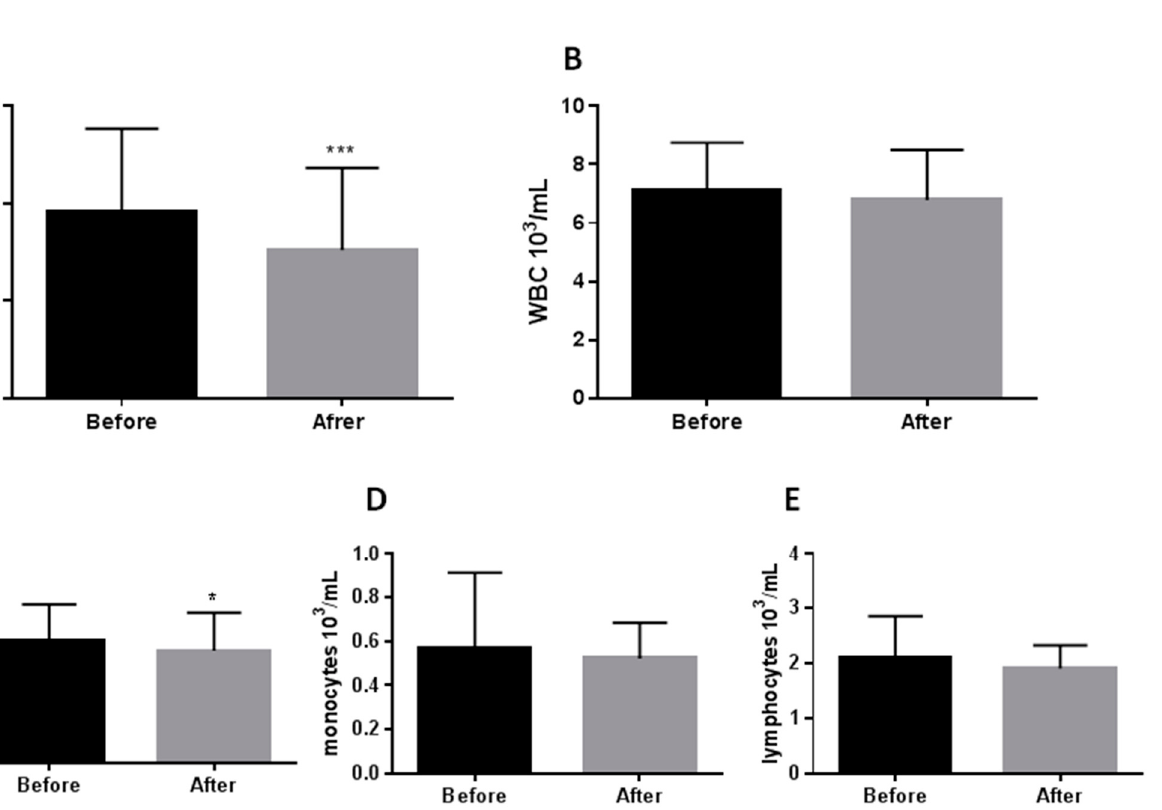
Figure 1. Effect of 8 week caloric restriction on serum myeloperoxidase activity ( A ), total white blood cell count ( B ), neutrophile count ( C ), monocyte count ( D ), and lymphocyte count ( E ). The data were analyzed using the paired t -tests (Gaussian distribution: the paired test; non-Gaussian distribution: Wilcoxon test). Significance difference Before vs. After: * p < 0.05, *** p < 0.001; Abbreviations: WBC—white blood cell count, PMN—polymorphonuclear leukocytes, MPO—myeloperoxidase.